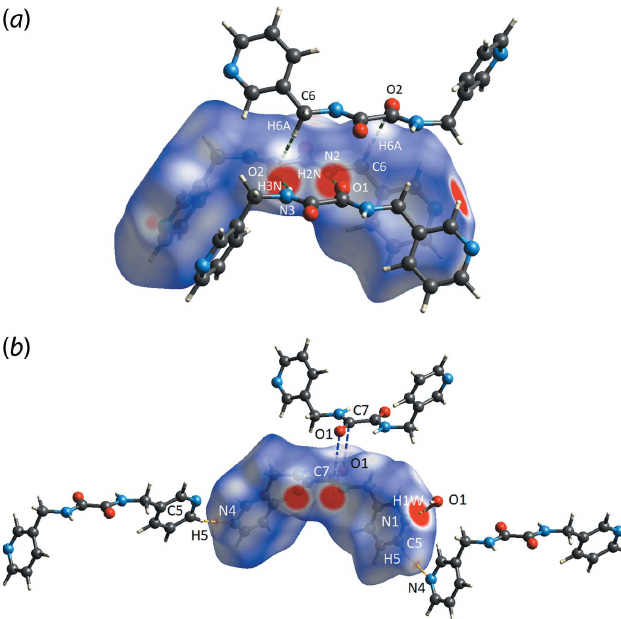
Figure 3 The d norm mapping of the Hirshfeld surface for 3 L H 2 in (I) within the range of (cid:5) 0.3259 to 1.0656 arbitrary units, showing the red spots for ( a ) N2—H2 N (cid:2)(cid:2)(cid:2) O1 (intense, connected by green dashed line), N3— H3 N (cid:2)(cid:2)(cid:2) O2 (intense, green dashed line) and C6—H6 A (cid:2)(cid:2)(cid:2) O2 (diminutive, green dashed line) interactions, ( b ) O1 W —H1 W (cid:2)(cid:2)(cid:2) N1 (intense, yellow dashed line), C5—H5 (cid:2)(cid:2)(cid:2) N4 (moderately intense, yellow dashed line) and C7 (cid:2)(cid:2)(cid:2) O1 (diminutive, blue dashed line) interactions.